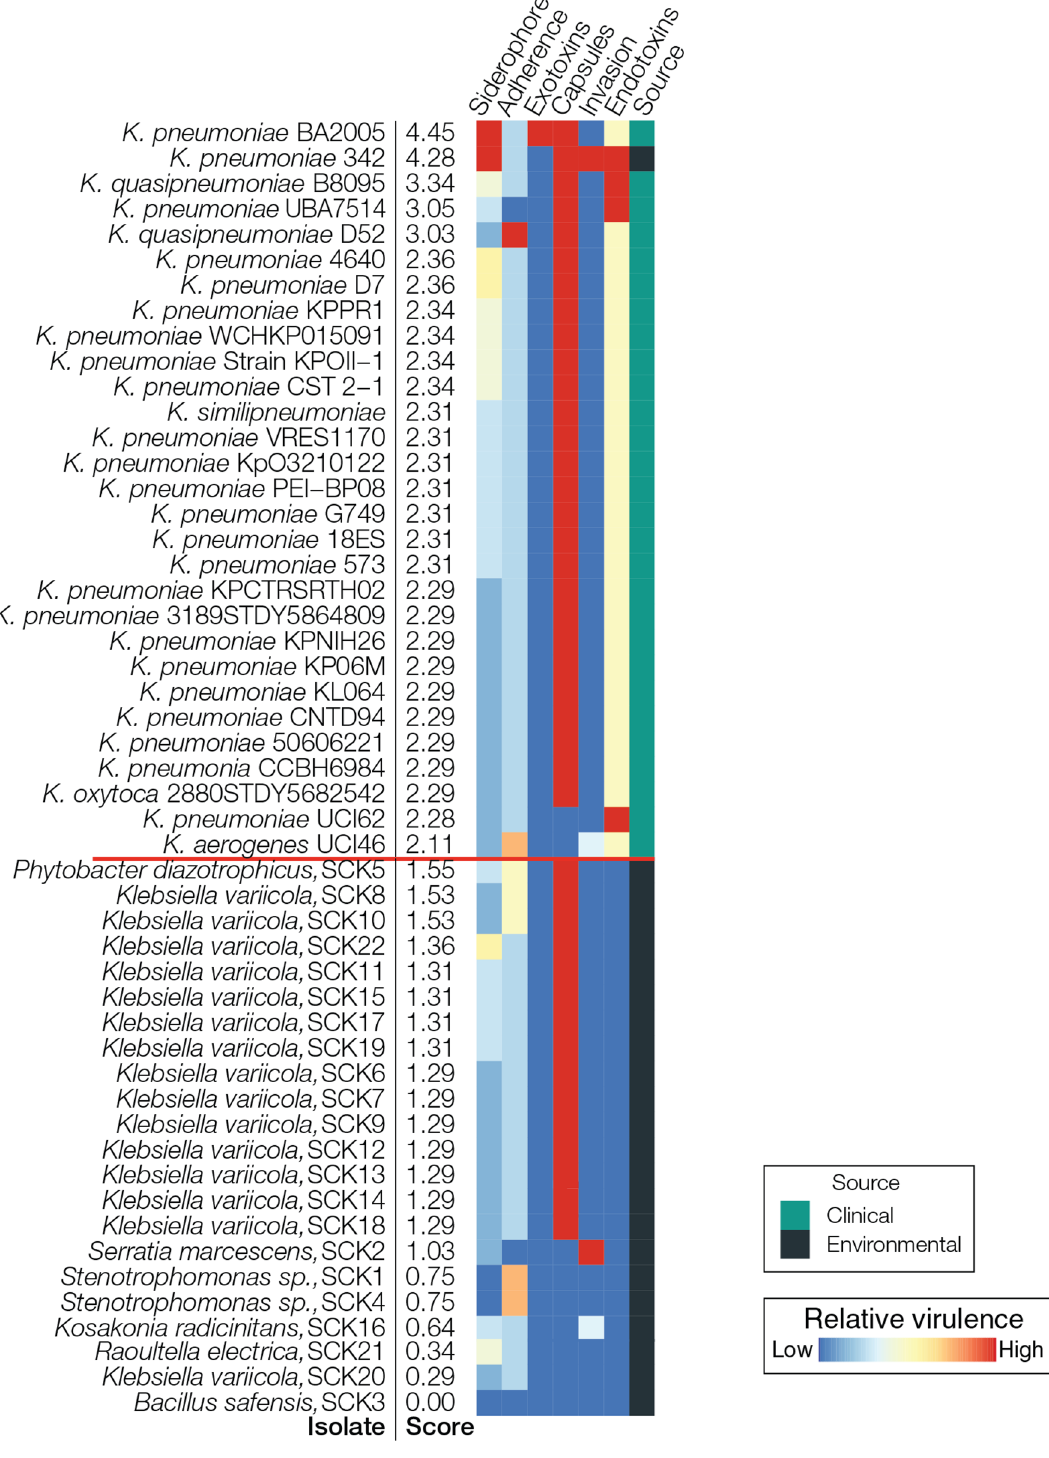
Figure 5. Comparison of predicted virulence profiles for clinical K. pneumoniae isolates compared to the environmental (sugarcane) bacterial isolates characterized here. As in Fig. 4, predicted virulence profiles for six classes of virulence factor genes are shown for each isolate. Isolate-specific virulence factor scores are shown for each isolate are based on the presence/absence profiles for the n = 44 virulence factor genes as described in the “Methods”. Relative virulence levels are color-coded as shown in the key (note that the color coding here is slightly different than seen in Fig. 4). The virulence factor genes are used to rank the genomes from most (left) to least (right) virulent. Clinical versus environmental samples are shown to the left and right, respectively, of the red line, based on their virulence